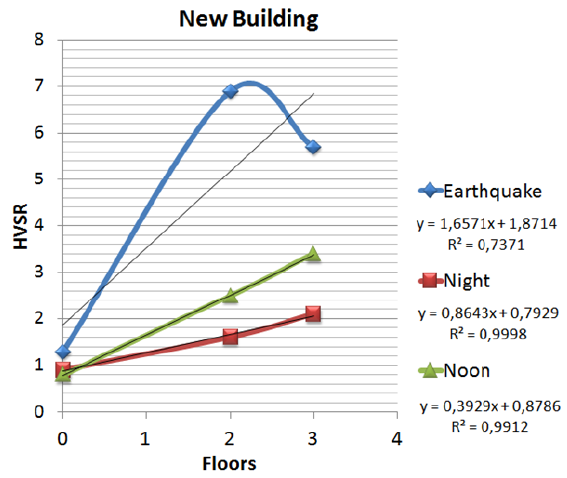
Figure 24. HVSR recordings from the 9 March 2013, 07:43UMT time seismic event (blue line), the 12 March 2013 midnight record- ing (red line) and the 12 March 2013 noon recording of the new building of TEI in Chania